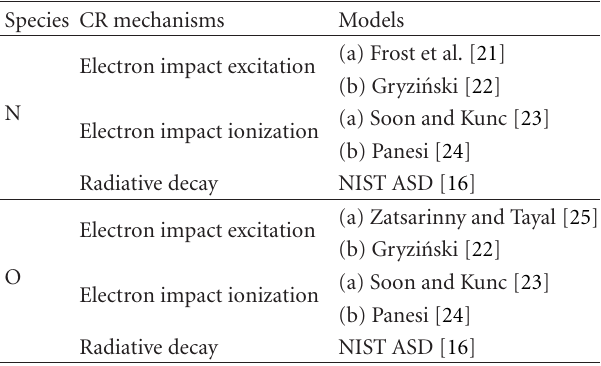
Table 1: Summary of the collisional-radiative mechanisms imple- mented for N and O in N 2 –O 2 mixtures.